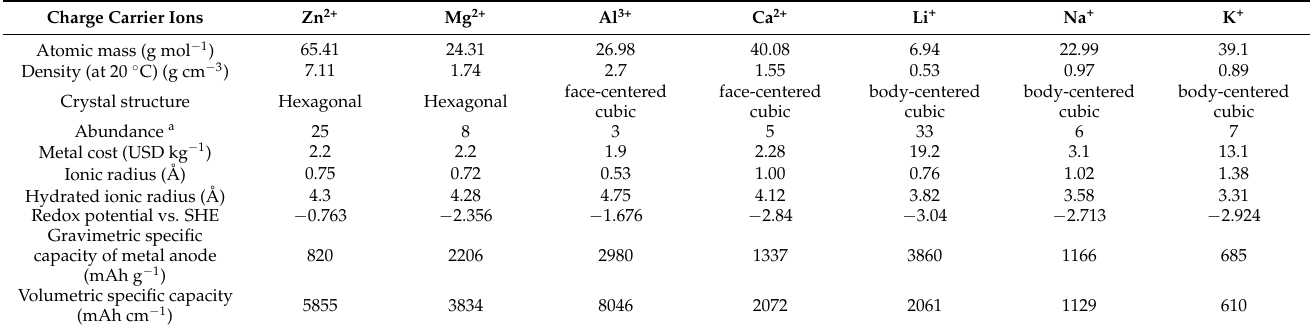
Table 1. Comparison of multivalent and monovalent metal-ions